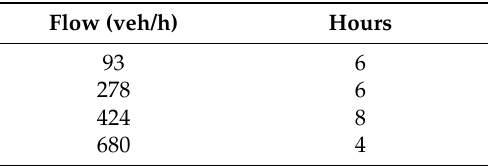
Table 2. Distribution of daily flow.